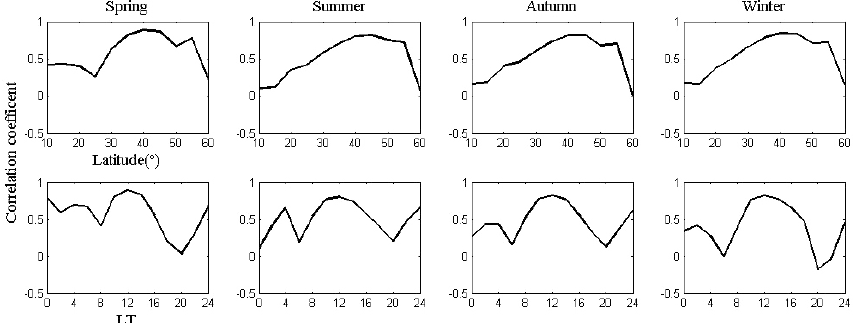
Figure 7. Correlation coefficient between the slab thickness and the F2 layer peak altitude for geographic latitude (top panels) and local time (bottom panels) in all seasons during the solar